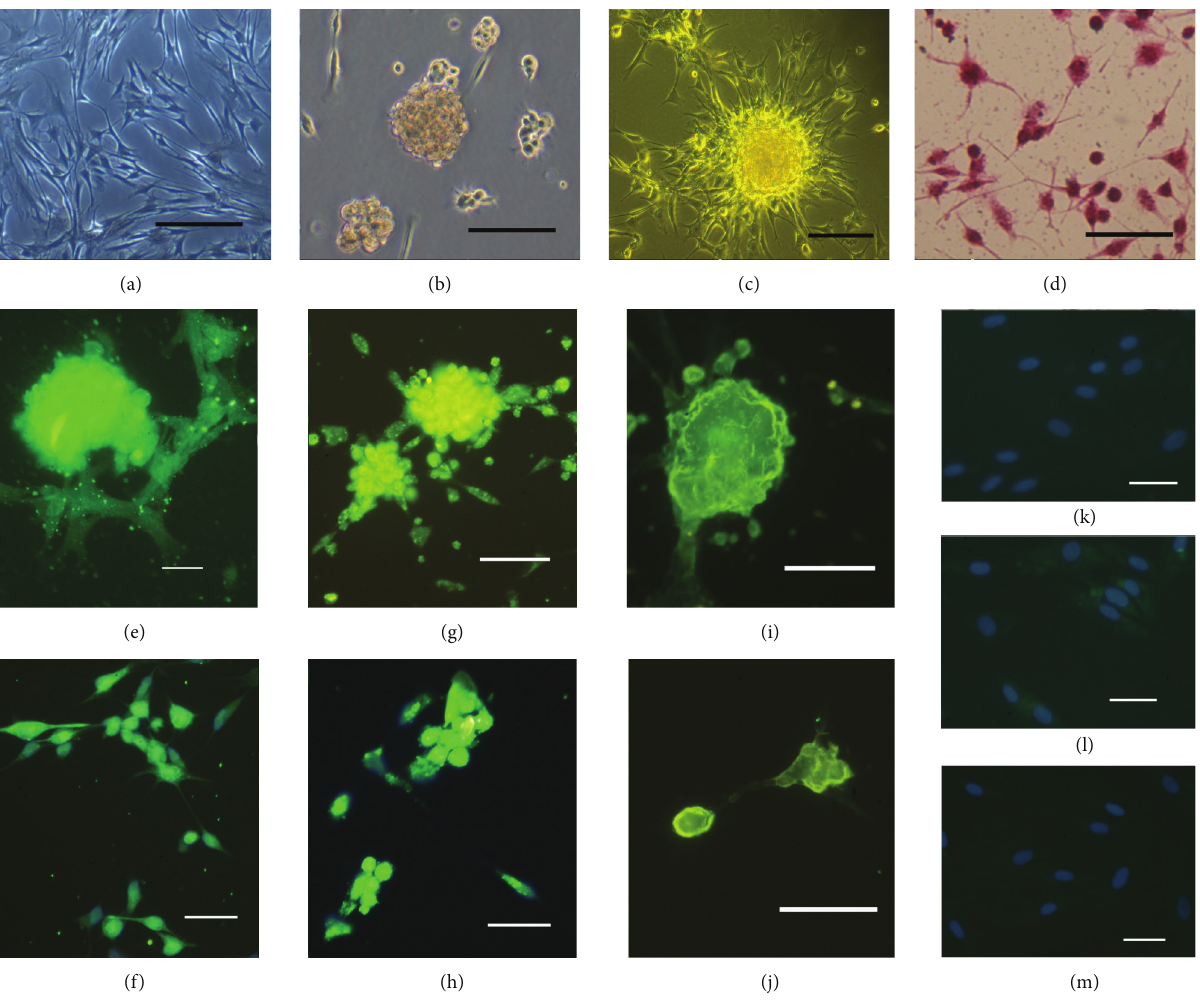
Figure 1: Morphology and immunofluorescence analysis of NTCSC-derived neurons. (a) Representative image of the cells at 80% confluence. (b) Representative image of cells cultured in serum-free medium. (c) The cells aggregated into groups following RA/SHH induction. (d) H&E staining revealed that the cells possessed neuron-like morphology following induction. After 48 hours of induction, the expression of Nestin ((e), (f)) and 𝛽 -III tubulin ((g), (h)) was observed. Synapsin I was also expressed in aggregated cells (i), and NeuN was present in the nuclei (j). The uninduced cells were negative for these markers (Nestin, (k); 𝛽 -III tubulin, (l); synapsin I, (m)). Nuclei ((f), (h), (k), (l), (m)) was staining with DAPI. Scale bar: ((c), (j), (k), (l), (m)): 100 𝜇 m; ((a), (b), (d), (e), (f), (g), (h), (i)): 200 𝜇